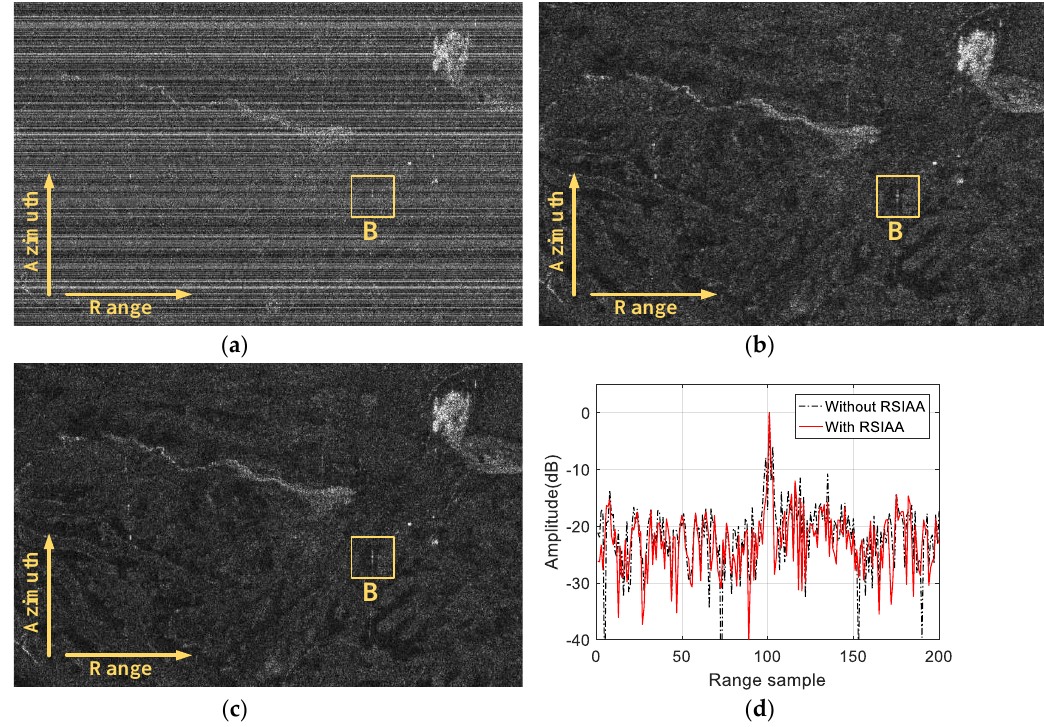
Figure 15. Imaging results of the second set of GF-3 SAR data. ( a ) The SAR image with RFI; ( b ) the SAR image without the RSIAA; ( c ) the SAR image with the RSIAA; ( d ) range profiles of the target in area B.